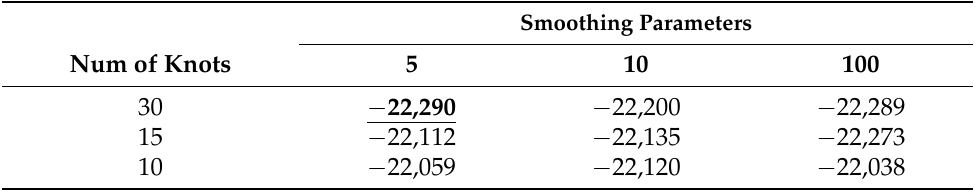
Table 11. DIC for Weibull distribution (4 January 2016, AGH, Tokyo, Japan).